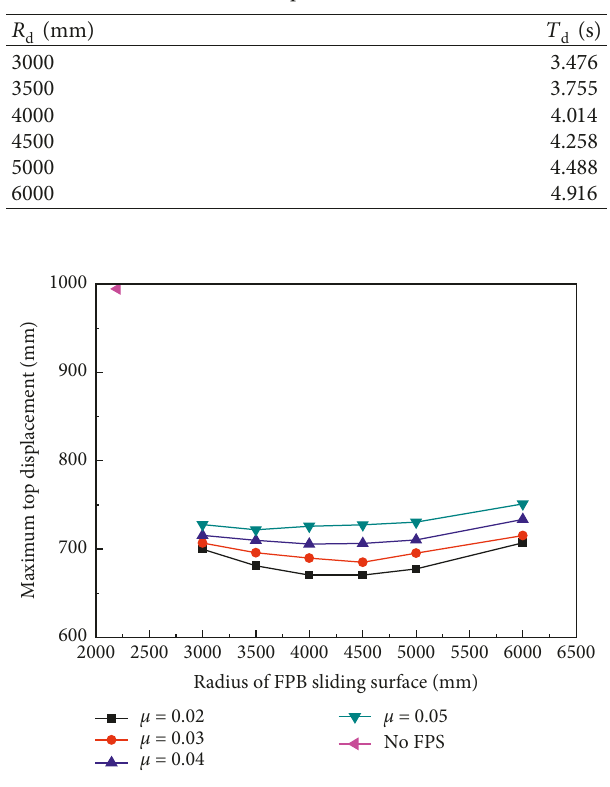
Figure 15: The maximum top displacement of T2 tower with R and μ in the X direction under L0689S wave.